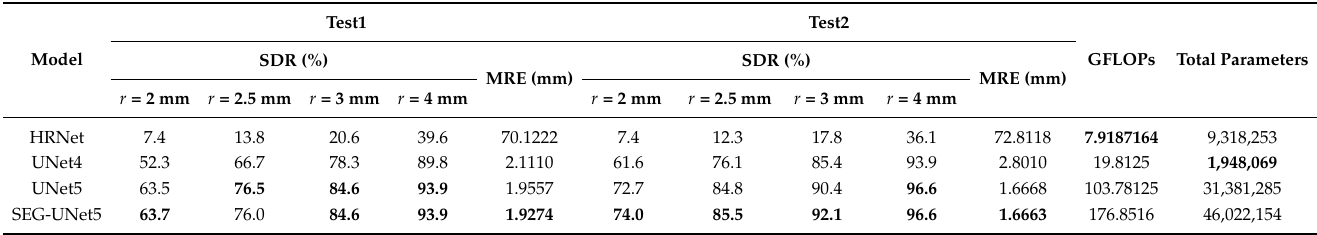
Table 3. 2D cephalometric radiograph dataset: The comparison results for our proposed improving- teacher method on the 2D cephalometric radiograph dataset. The student model is UNet4, while the teacher model is UNet5 and